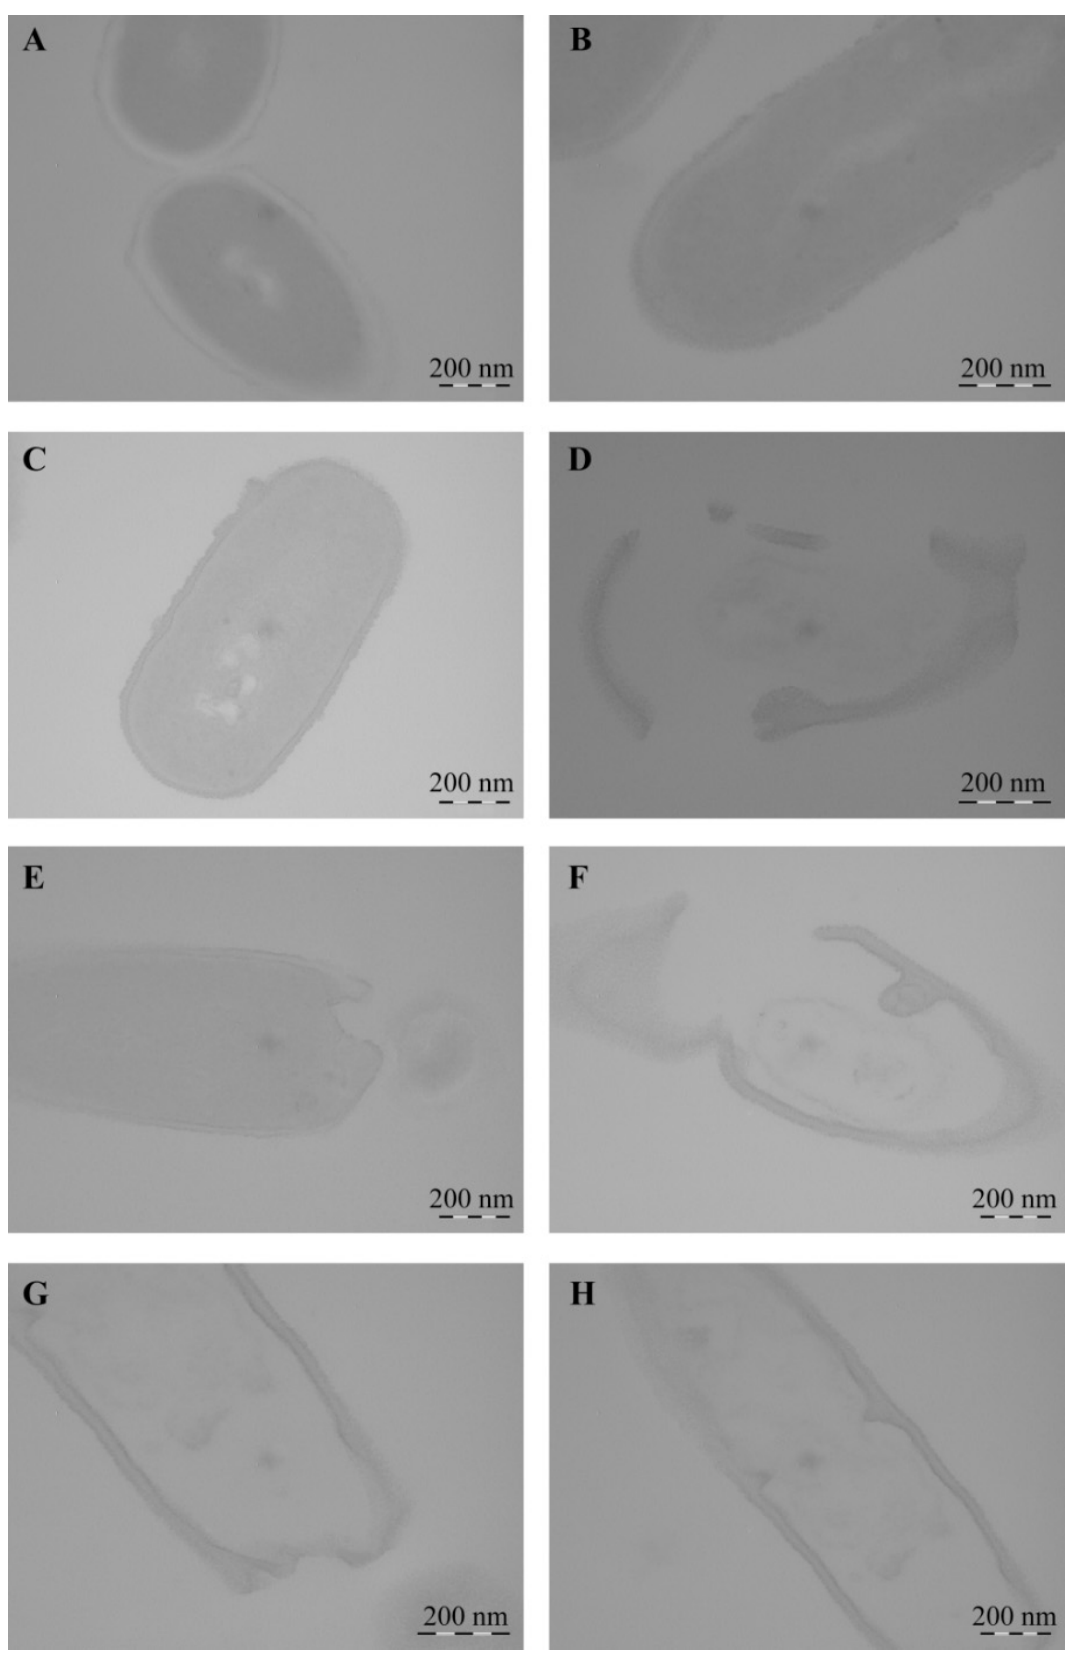
Figure 16. TEM micrographs of Cms bacteria in the control ( A , B ) and treated with AG-Mn ( C , D ), AGS-Mn ( E , F ), and κ -CG-Mn ( G , H ). Longitudinal optical section of cells.